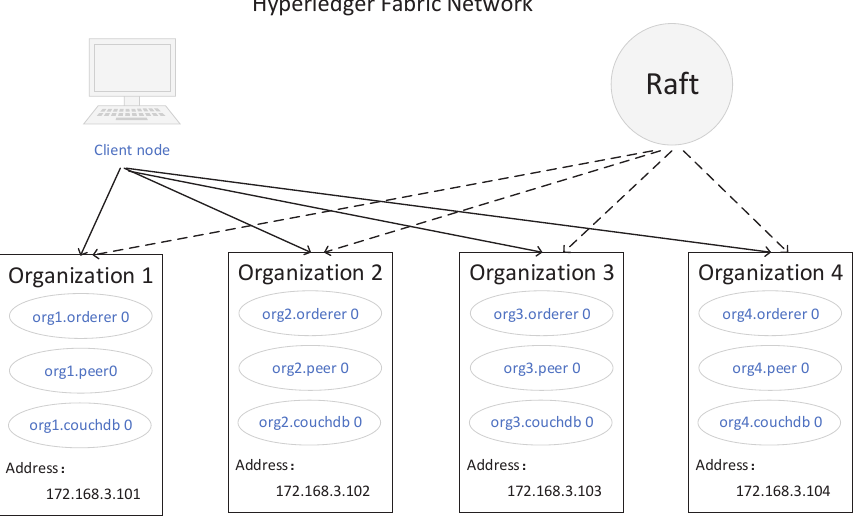
Figure 7. Hyperledger Fabric network